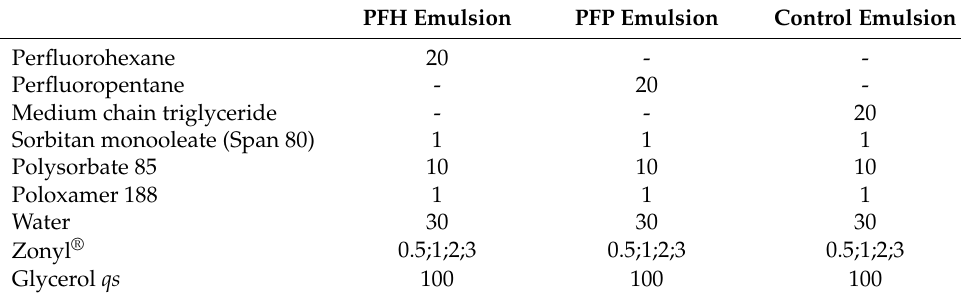
Table 1. Composition of emulsions in